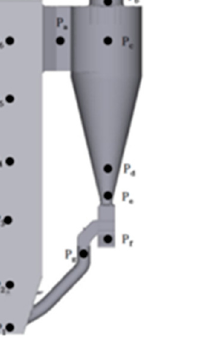
Figure 2. Distribution of pressure measurement points.